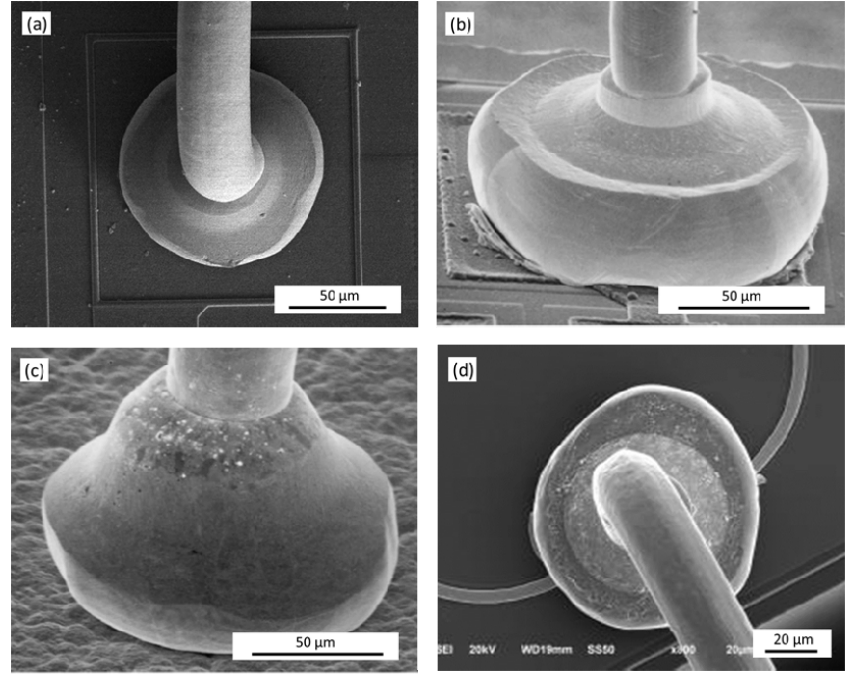
Figure 8. The shape of the ball bonded point with ICADs of: ( a ) 64 μ m; ( b ) 51 μ m; ( c ) 76 μ m; ( d ) the MBD is too large and overflows the pad due to the small ICAD.